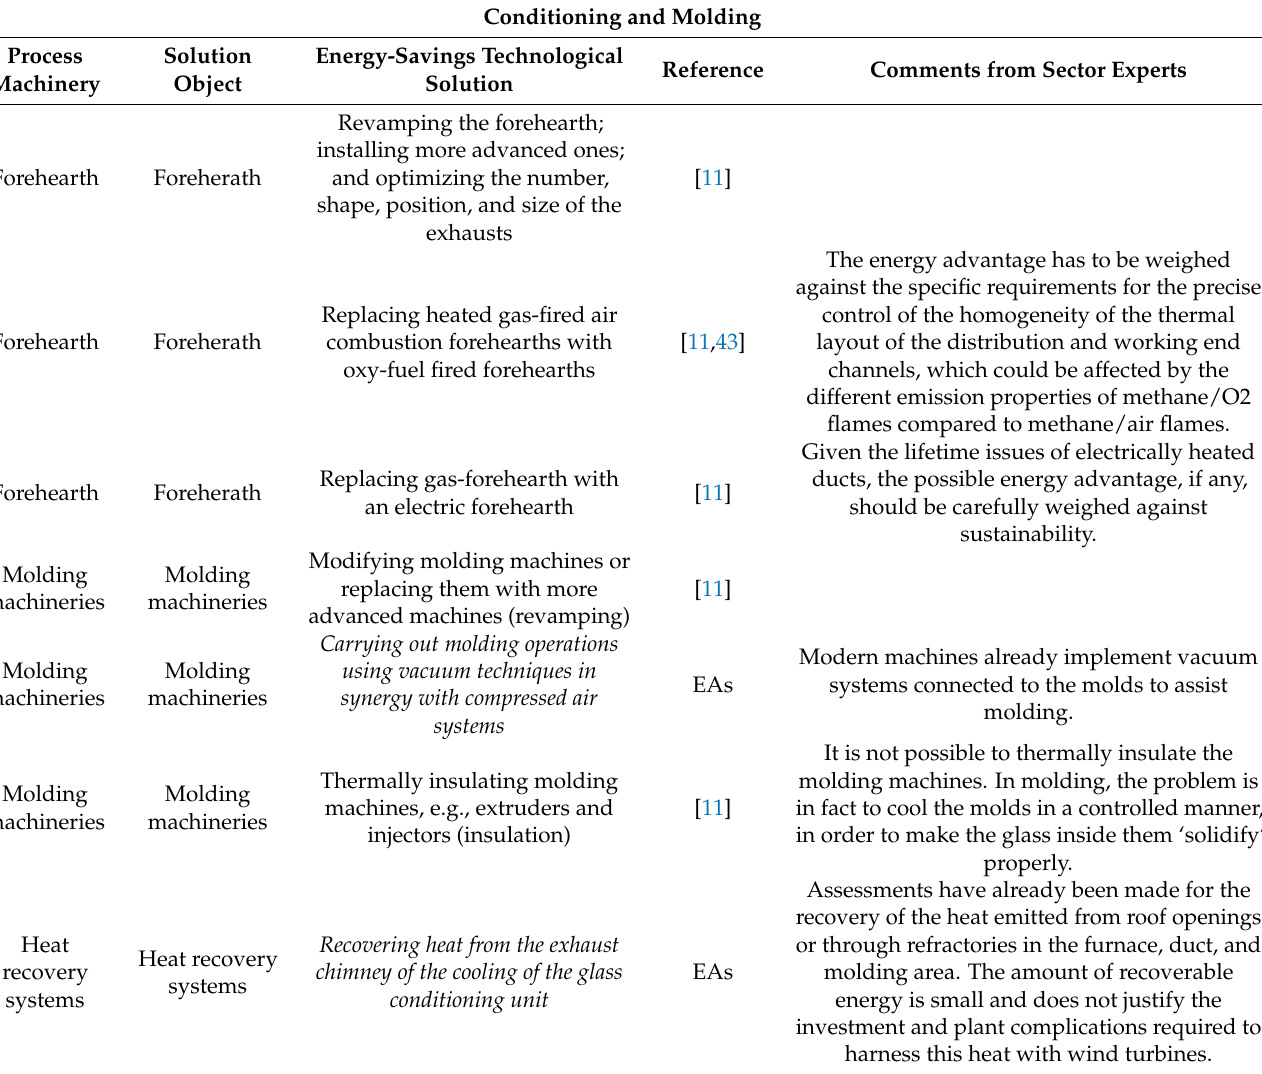
Table A3. Technology energy-savings for conditioning and molding.